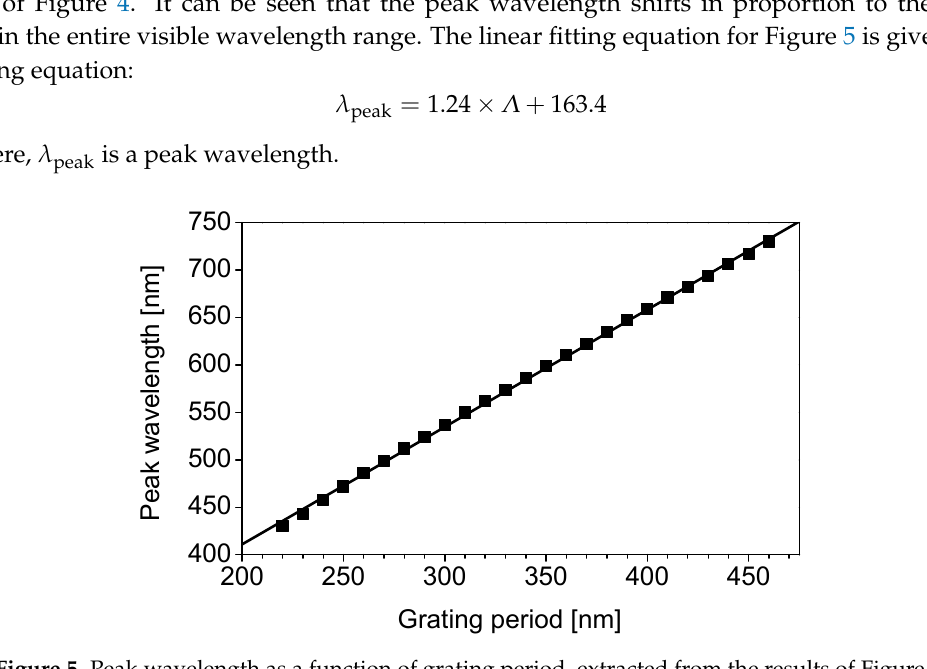
Figure 5. Peak wavelength as a function of grating period, extracted from the results of Figure 4.